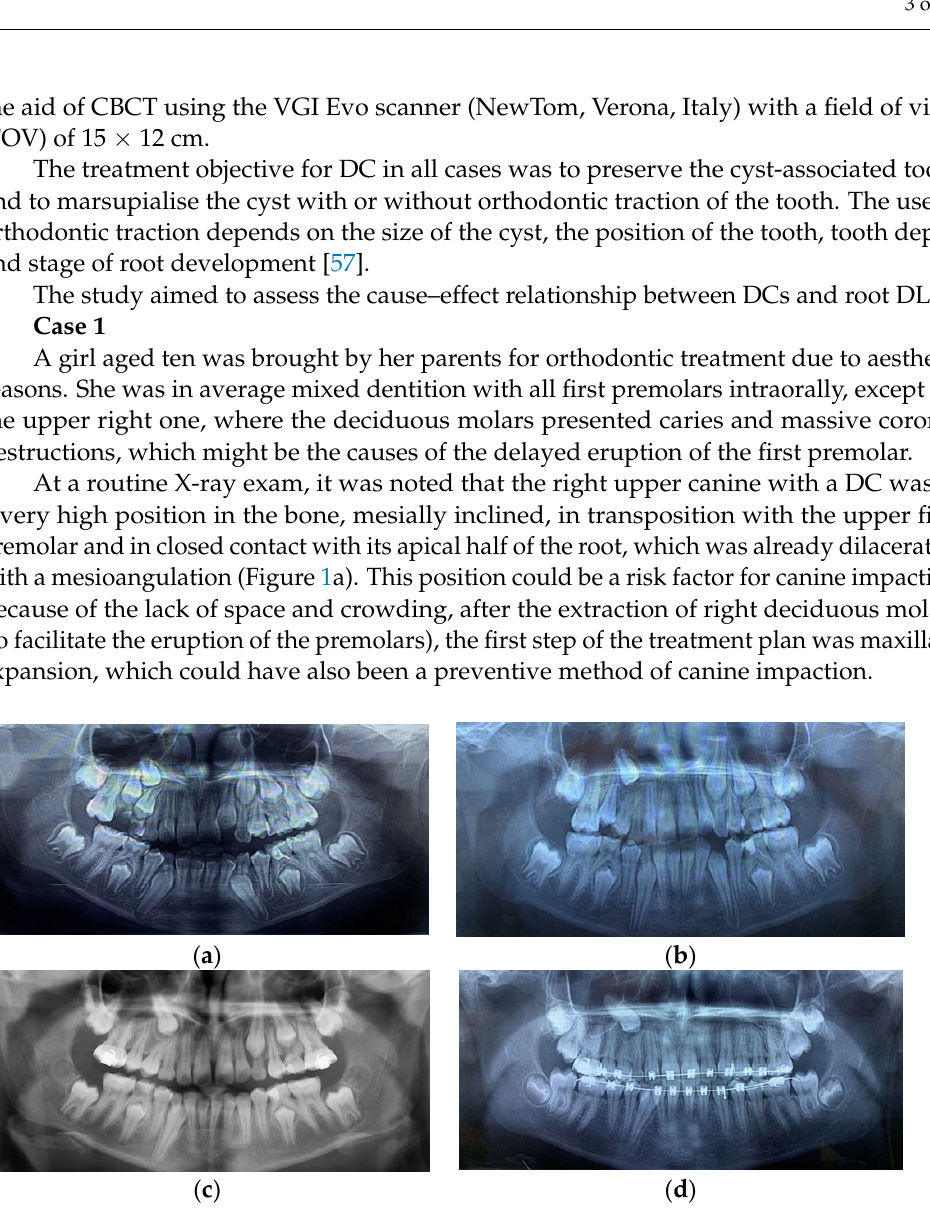
Figure 1. ( a ) Initial panoramic X-ray showing the upper right canine in a very high position and transposition with the first premolar. ( b , c ) Different types of root DL affecting right premolars. No improvement regarding the position of the right canine after maxillary expansion. ( d ) The upper left second premolar also has a root DL.